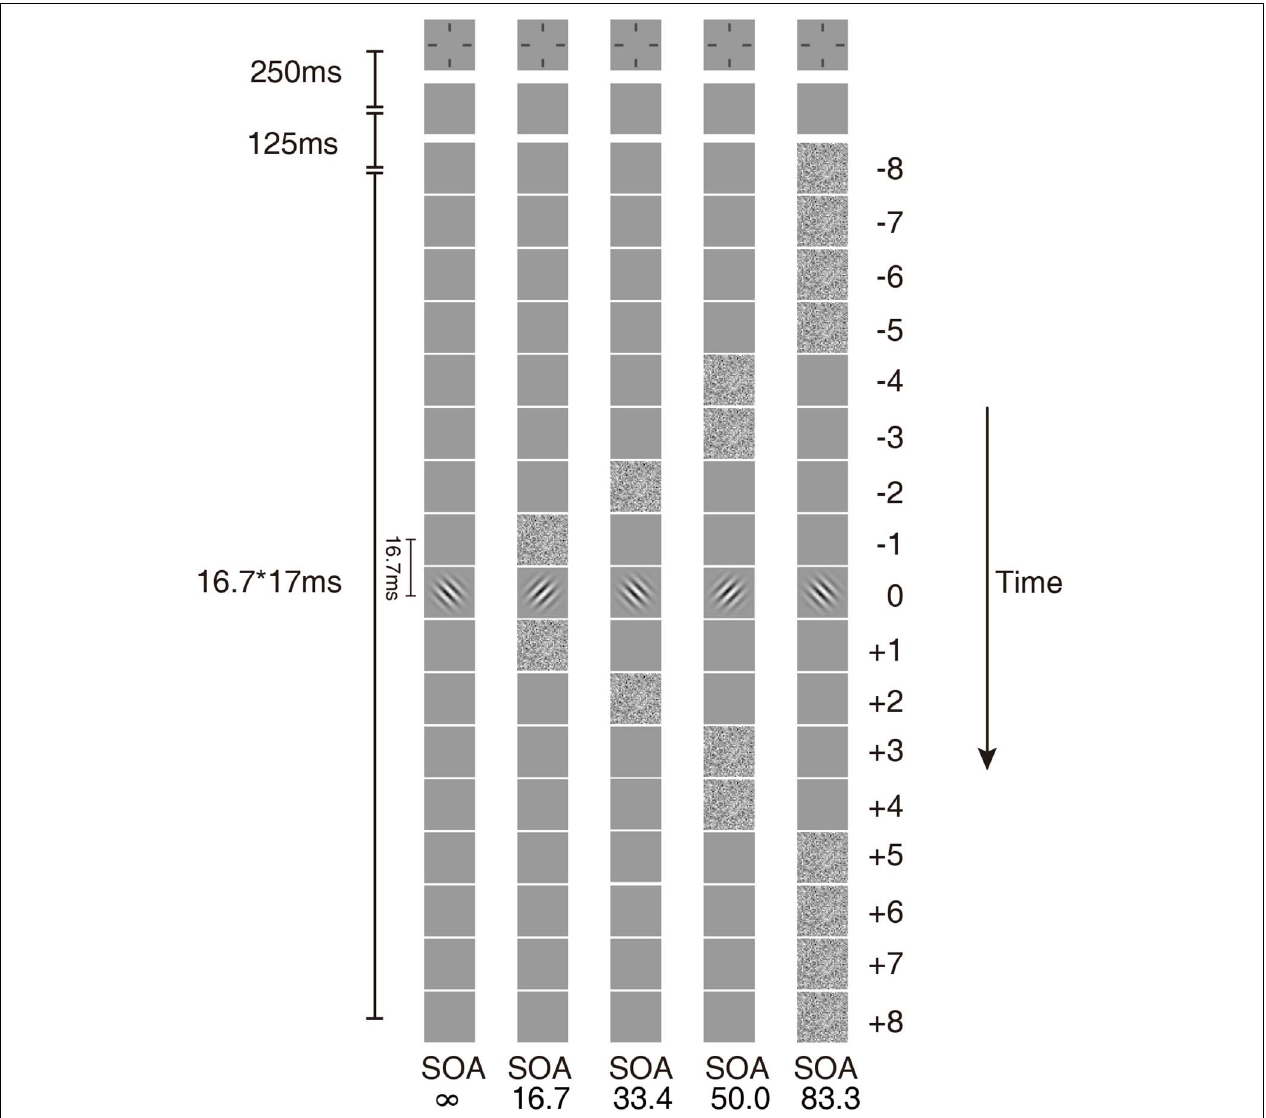
FIGURE 1 | Temporal configurations of the five masking conditions in the experiment. In condition SOA ∞ , only the Gabor target was presented. In the other four conditions, the external noise masks were presented symmetrically around the target.